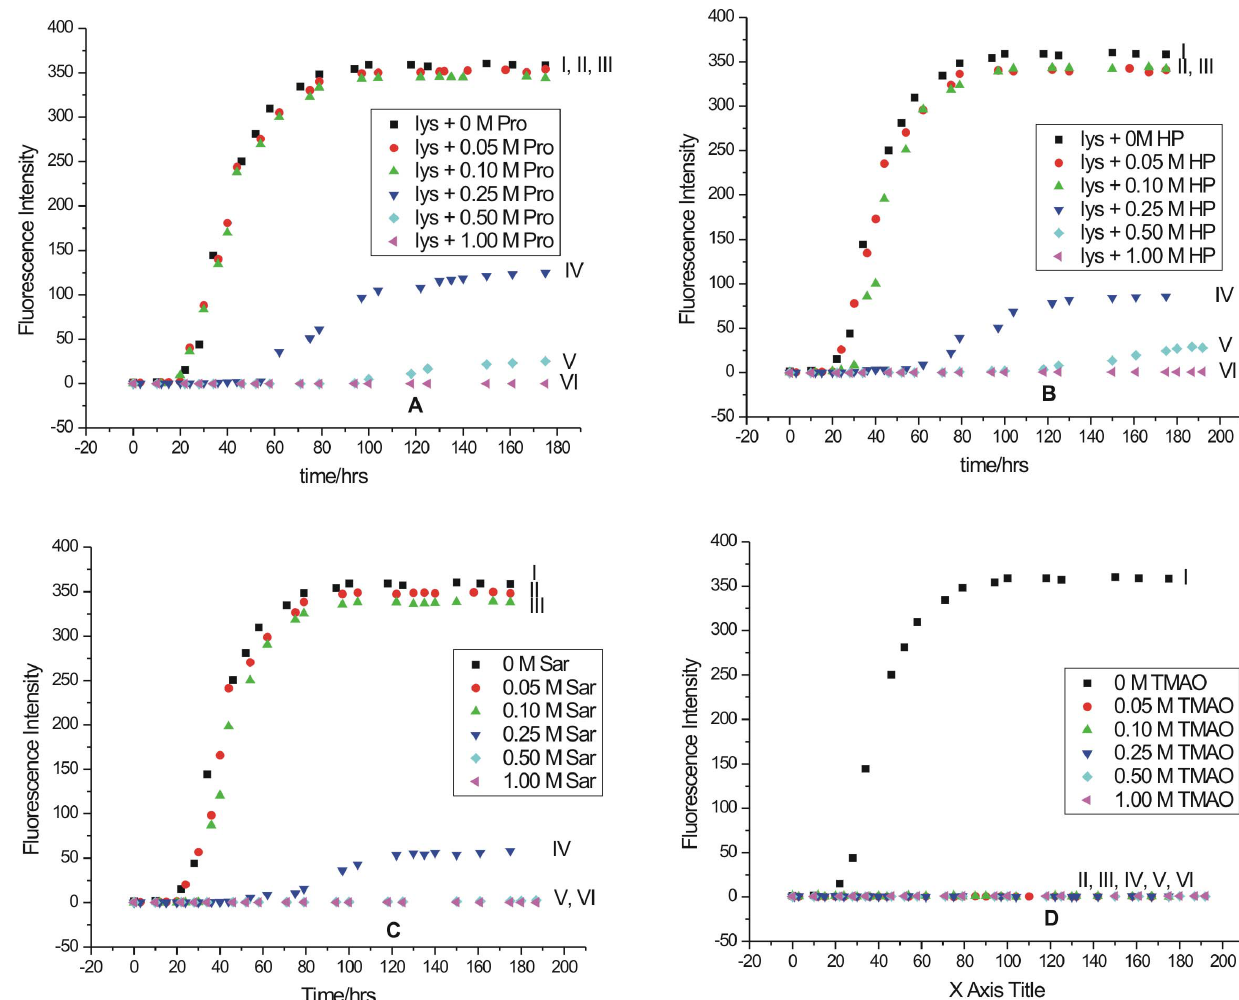
Figure 4. Kinetics of lysozyme fibril extension in absence and in presence of different concentration of osmolytes (A) L-proline, (B) 4-hydroxy-L-proline, (C) sarcosine, and (D) trimethylamine-N-oxide studied by monitoring the changes in fluorescence emission intensity as a function of time.